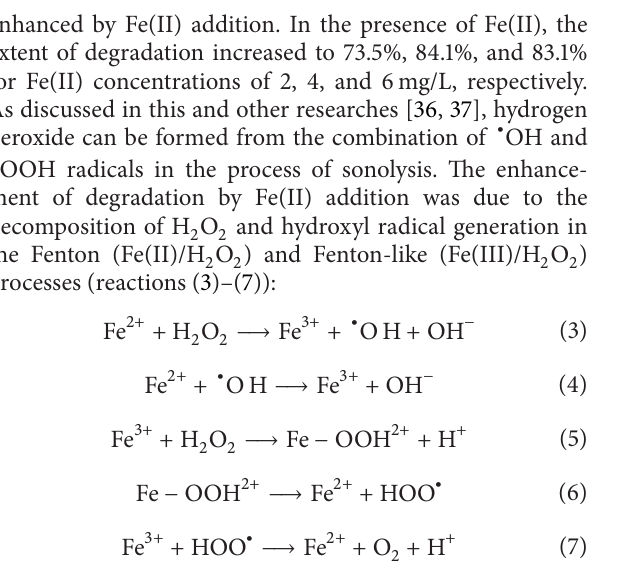
Figure 8: Effect of TiO 2 on ultrasonic degradation of fuchsin basic (initial dye concentration = 10 𝜇 molL −1 , ultrasonic power = 400W, ultrasonic frequency = 25kHz, tempetature = 22 ∘ C, and pH =